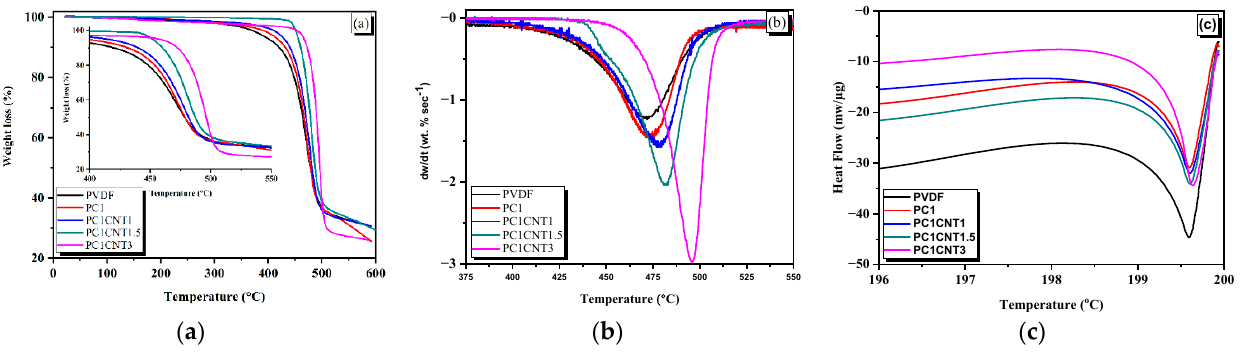
Figure 6. TG ( a ), DTA ( b ), and DSC ( c ) curves of blank and different weight percent loaded nano-fillers PVDF nanocomposites films.